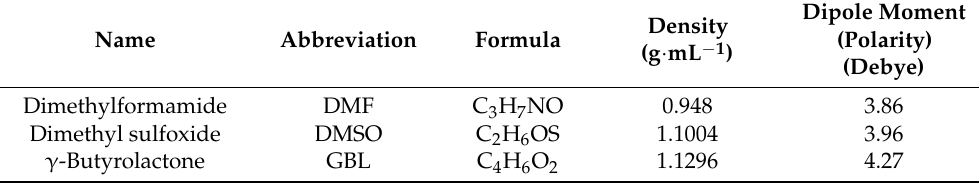
Table 1. Properties of the solvents studied in this